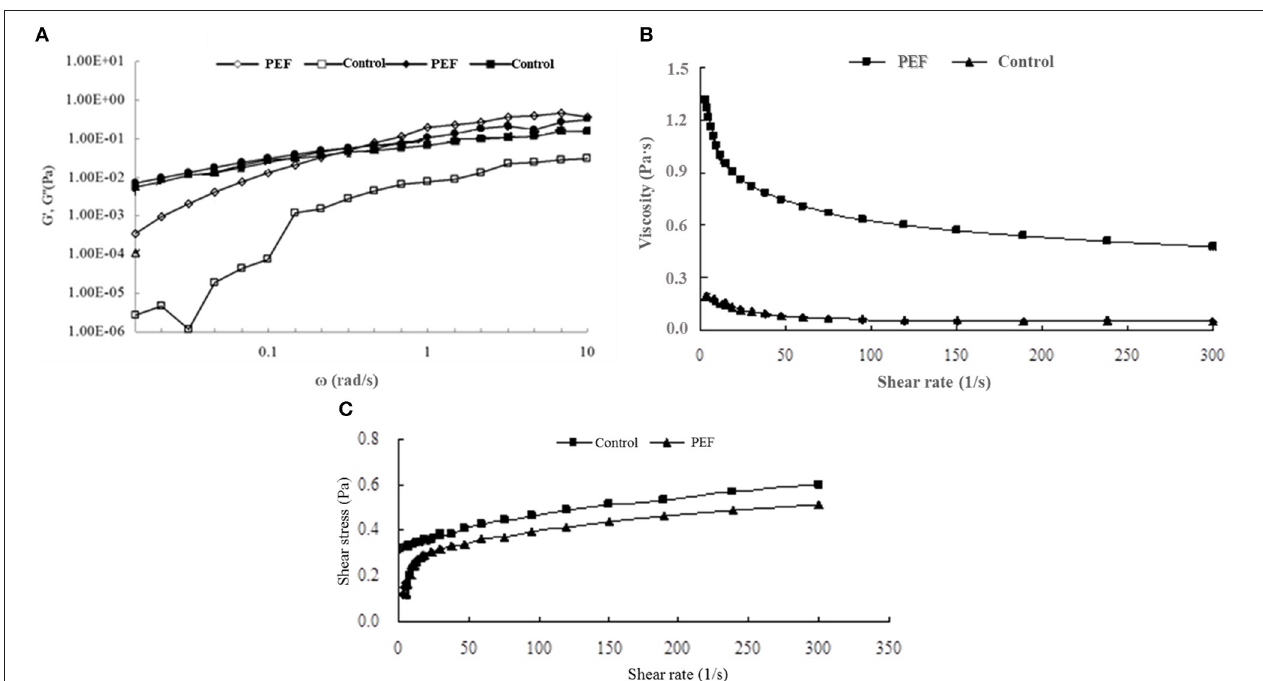
FIGURE 4 | Effects of PEF and control SDF from orange peel on antioxidant activity. (A) DPPH radical scavenging capacities; (B) ABTS radical scavenging capacities; (C) ferric ion reducing capacity. Mean values with different letters are significantly different ( p < 0.05). PEF treatment parameters: electric field intensities 6.0 kV/cm, the number of pulses 30, the extraction time of 20min, liquid-solid ratios of 15:1 and temperature of 45 ◦ C. The results were expressed as mean ± standard deviation ( n = 3), the different letters indicated that the difference was significant ( P < 0.05) and the same letter was expressed as insignificant difference.